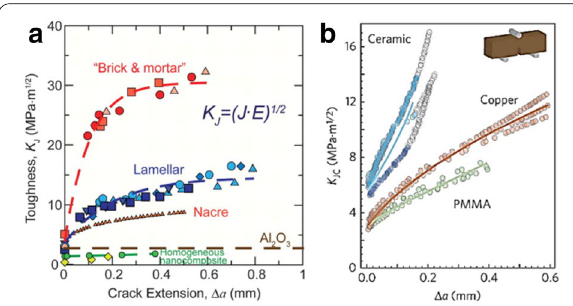
Figure 13 ( a ) The exception toughness of the composites with different structures [99]; ( b ) The crack growth resistance curves of the composites with anisotropic structure